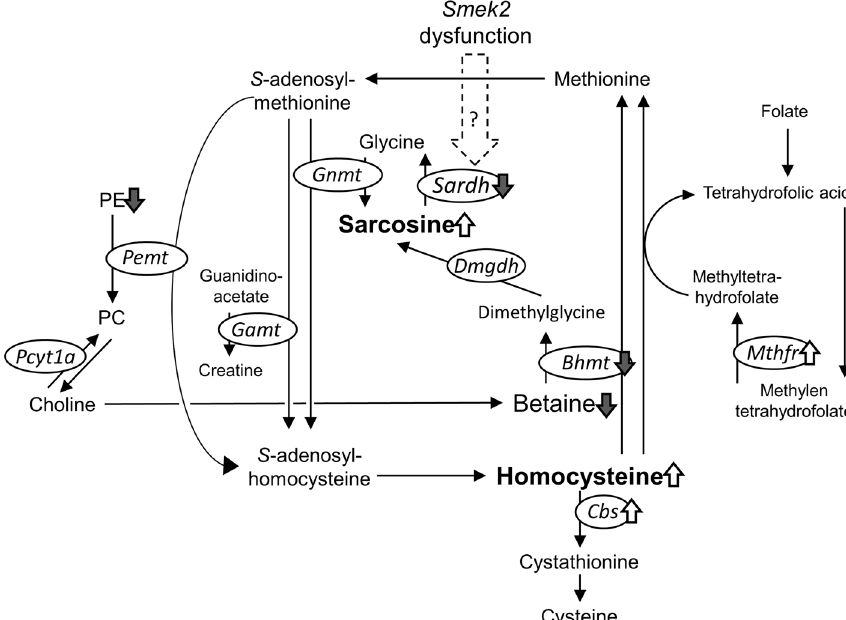
Figure 3. Diagram of methionine/homocysteine metabolism. Reactions are shown as arrows in lines. Gene symbols for related enzymes are described in circles. Bhmt ; betaine-homocysteine methyltransferase, Cbs ; cystathionine beta-synthase, Dmgdh ; dimethylglycine dehydrogenase, Gamt ; guanidinoacetate methyltransferase, Gnmt ; glycine N-methyltransferase, Ms ; methionine synthase, Mthfr ; methylenetetrahydrofolate reductase, Pcyt1a ; phosphate cytidylyltransferase 1, Pemt ; phosphatidylethanolamine N-methyltransferase, Sardh ; sarcosine